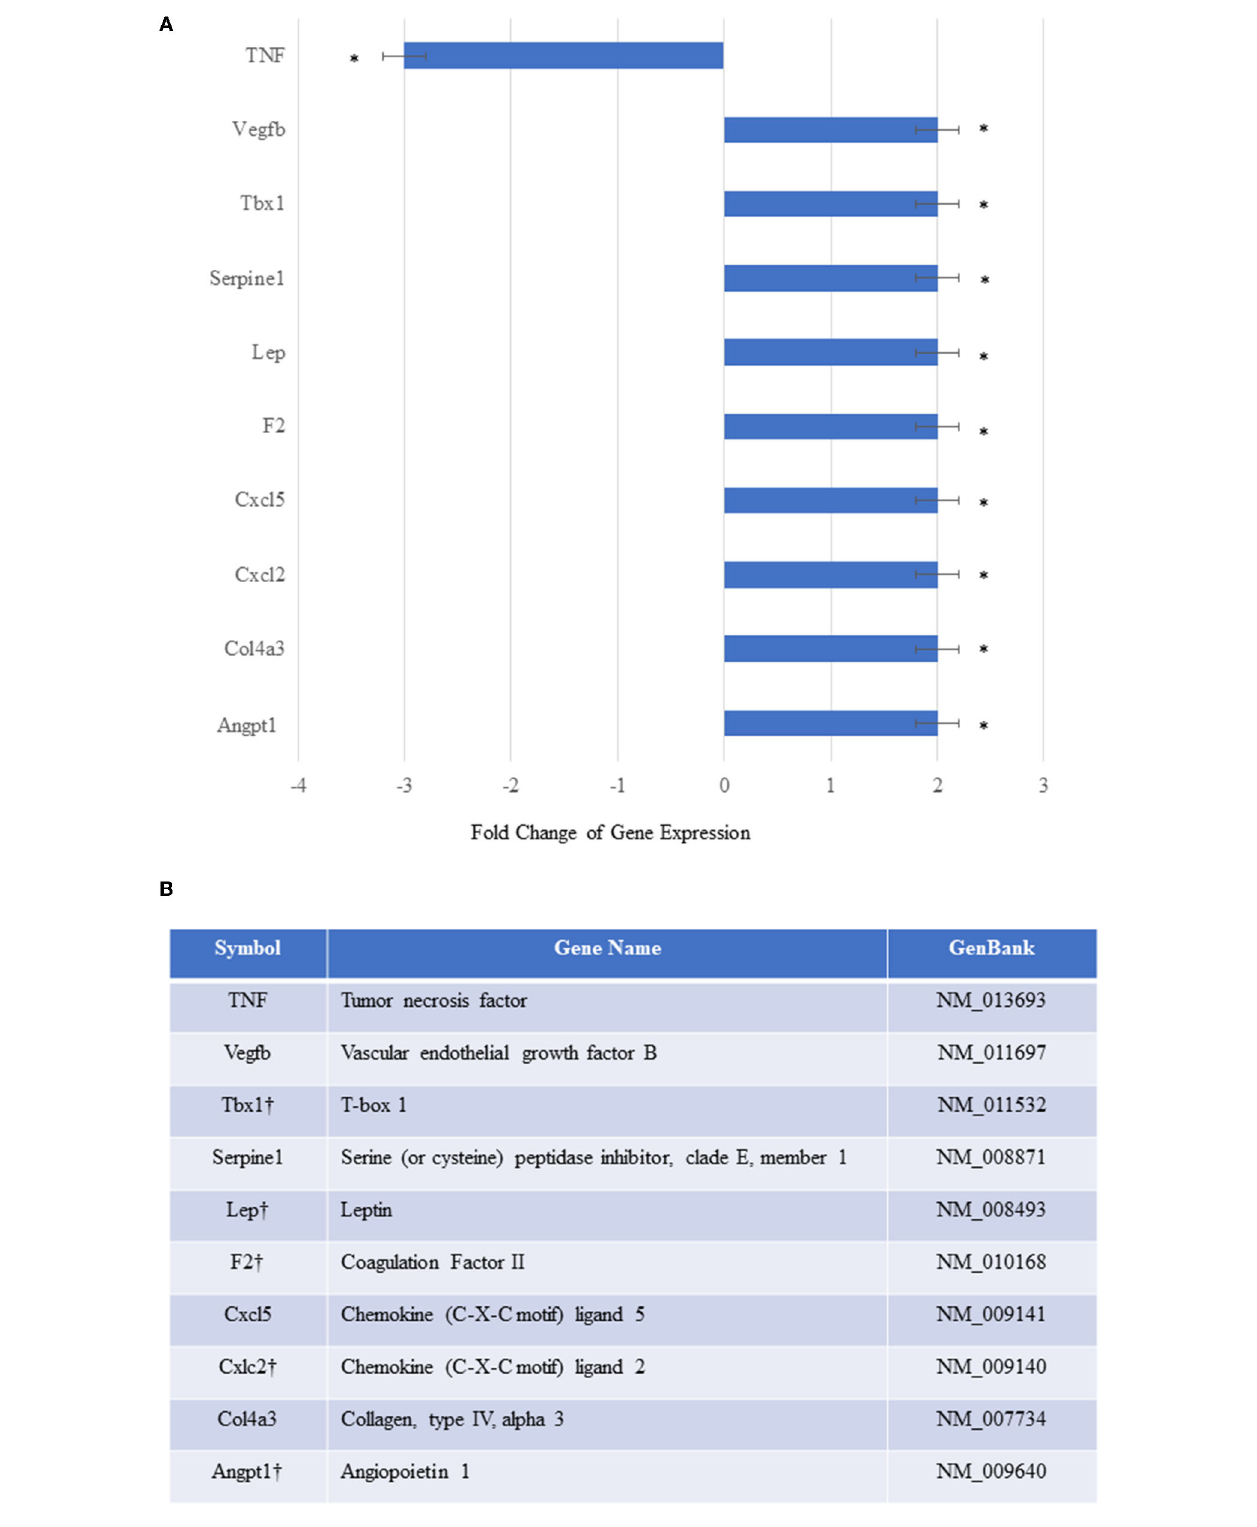
FIGURE 6 | In vivo relative gene expression changes in the ischemic thigh tissue of mice treated with MSC Eselectin − GFP vs. MSC GFP . (A) Expression of several chemokine/cytokine mRNA was significantly higher in the ischemic thigh muscle treated with MSC Eselectin − GFP vs. MSC GFP measured by quantitative PCRArray by post-operative day 21. However, tumor necrosis factor (TNF) was significantly downregulated. Equal portions of RNA from three mice in each treatment group were